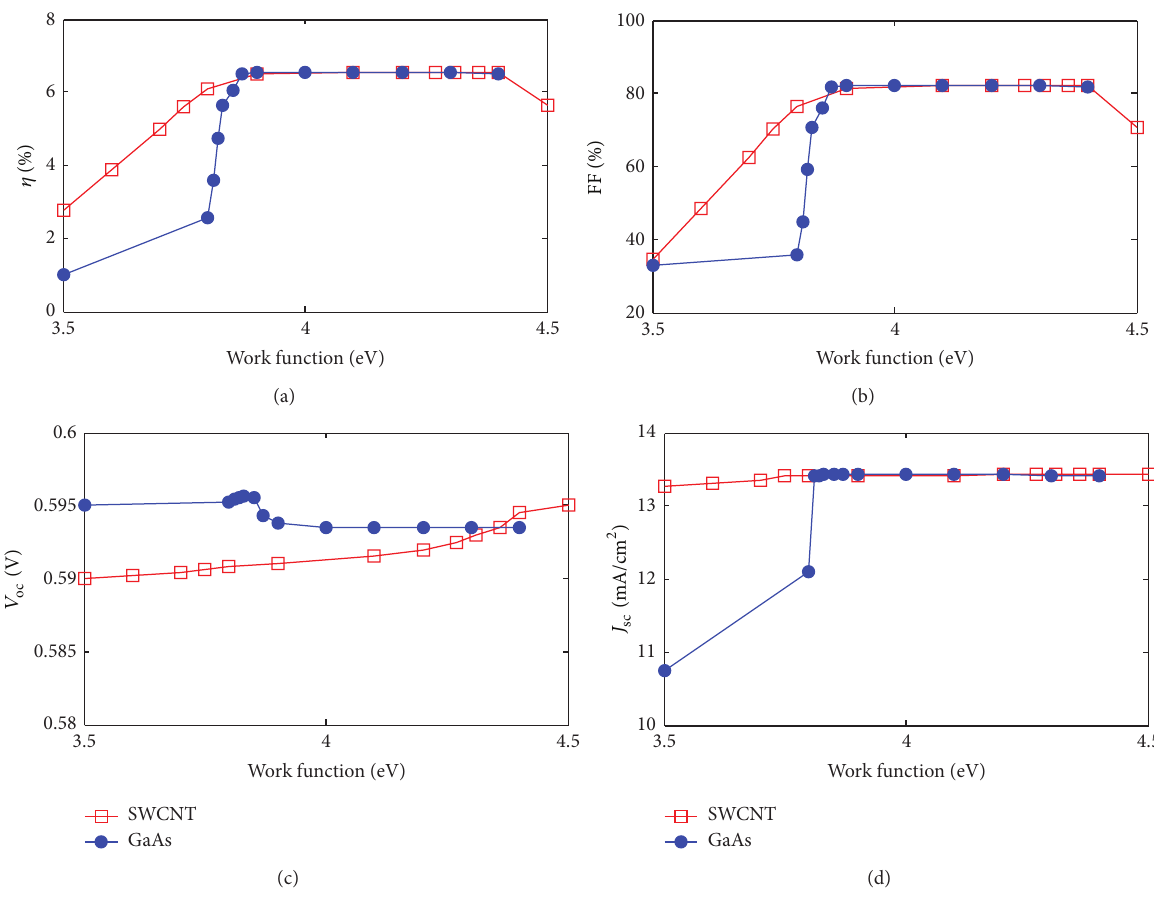
Figure 6: The effect of electron affinity ( 𝜒 ) on the performance parameters.